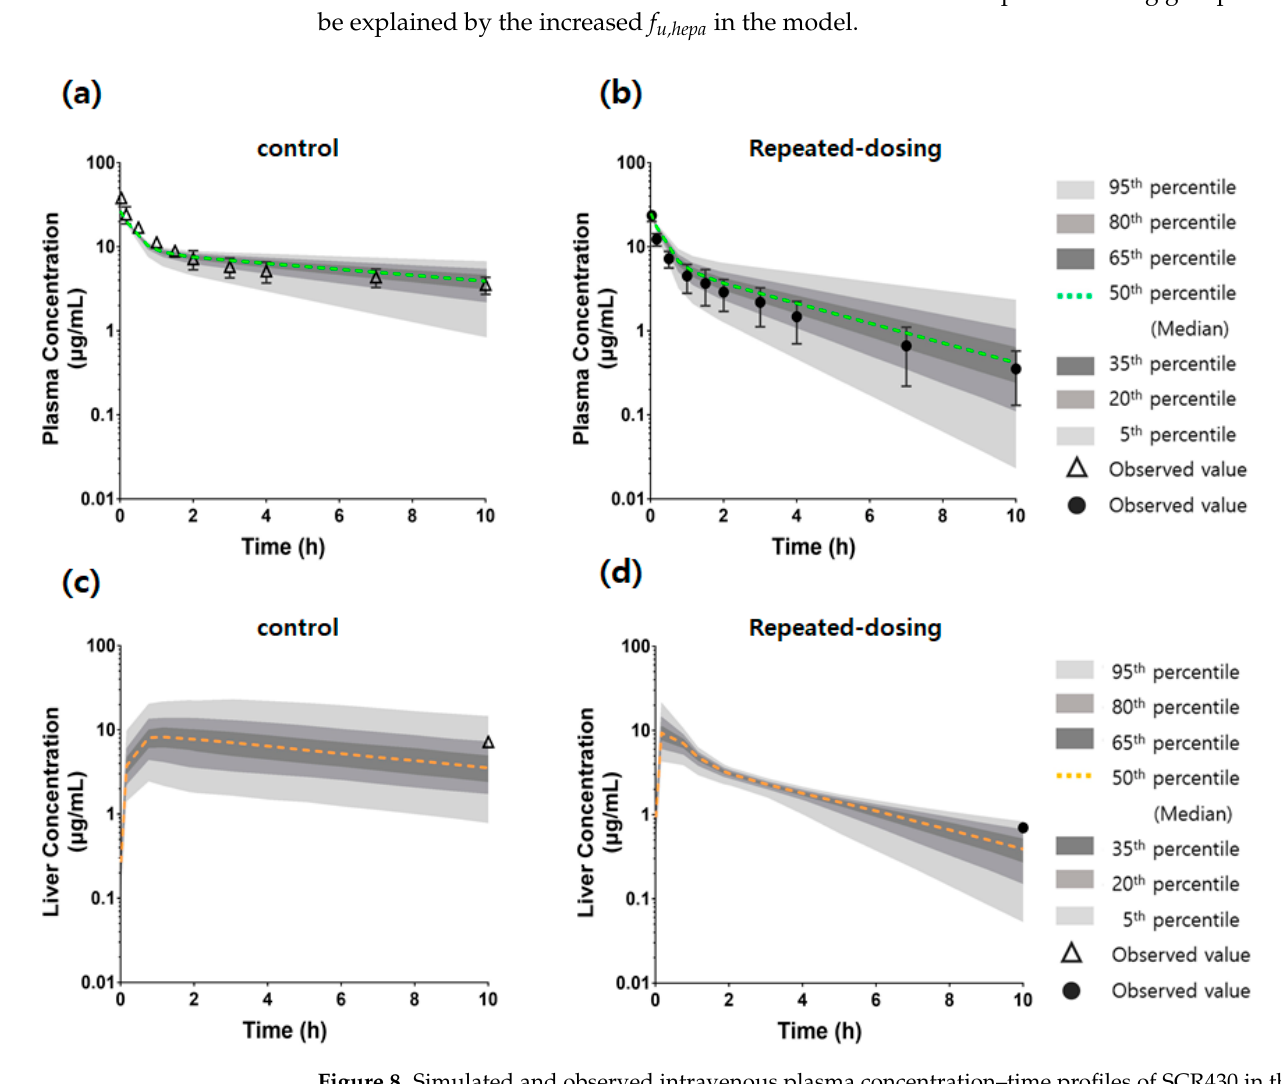
Figure 8. Simulated and observed intravenous plasma concentration–time profiles of SCR430 in the control and repeated-dosing groups. The Monte Carlo simulation curves (shaded region) and the observed data for the SCR430 concentrations in the plasma and liver of the control (open triangle; ( a , c )) and repeated-dosing (closed circle; ( b , d )) groups after intravenous administration at a dose of 3 mg kg − 1 . The shaded region represents 95% confidence intervals around the 5th and 95th (light gray-shaded region), 50th (green or yellow dotted line), 20th and 80th (middle gray-shaded region), and 35th and 65th (deep gray-shaded region) percentiles of the simulated concentration. The observed plasma concentrations are represented by means (symbols) and standard deviations (bars). The observed liver concentration is represented by a mean value.